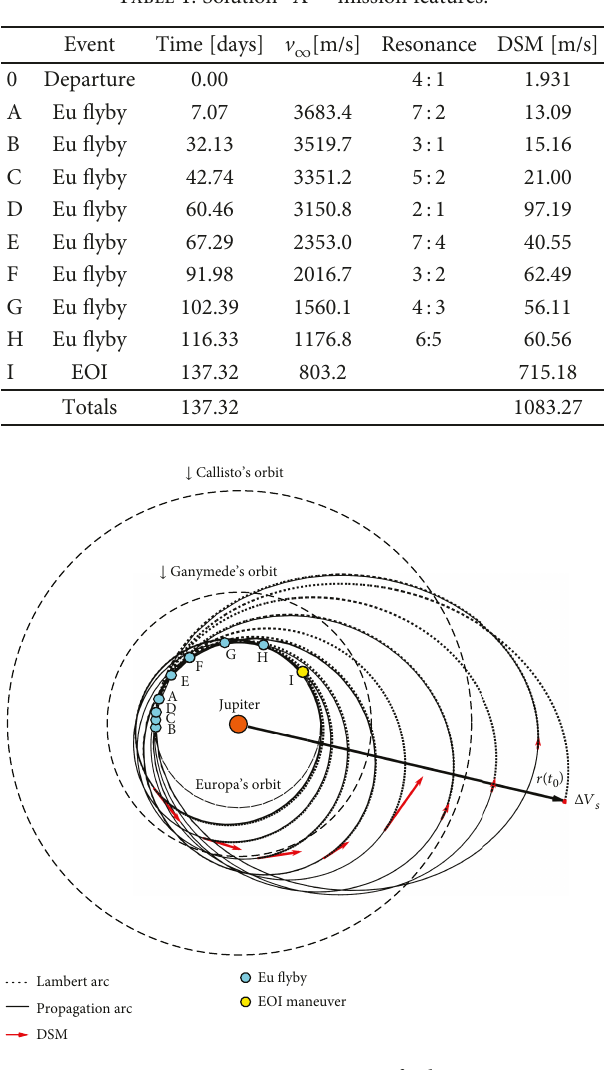
Figure 6: Jovicentric trajectory of solution